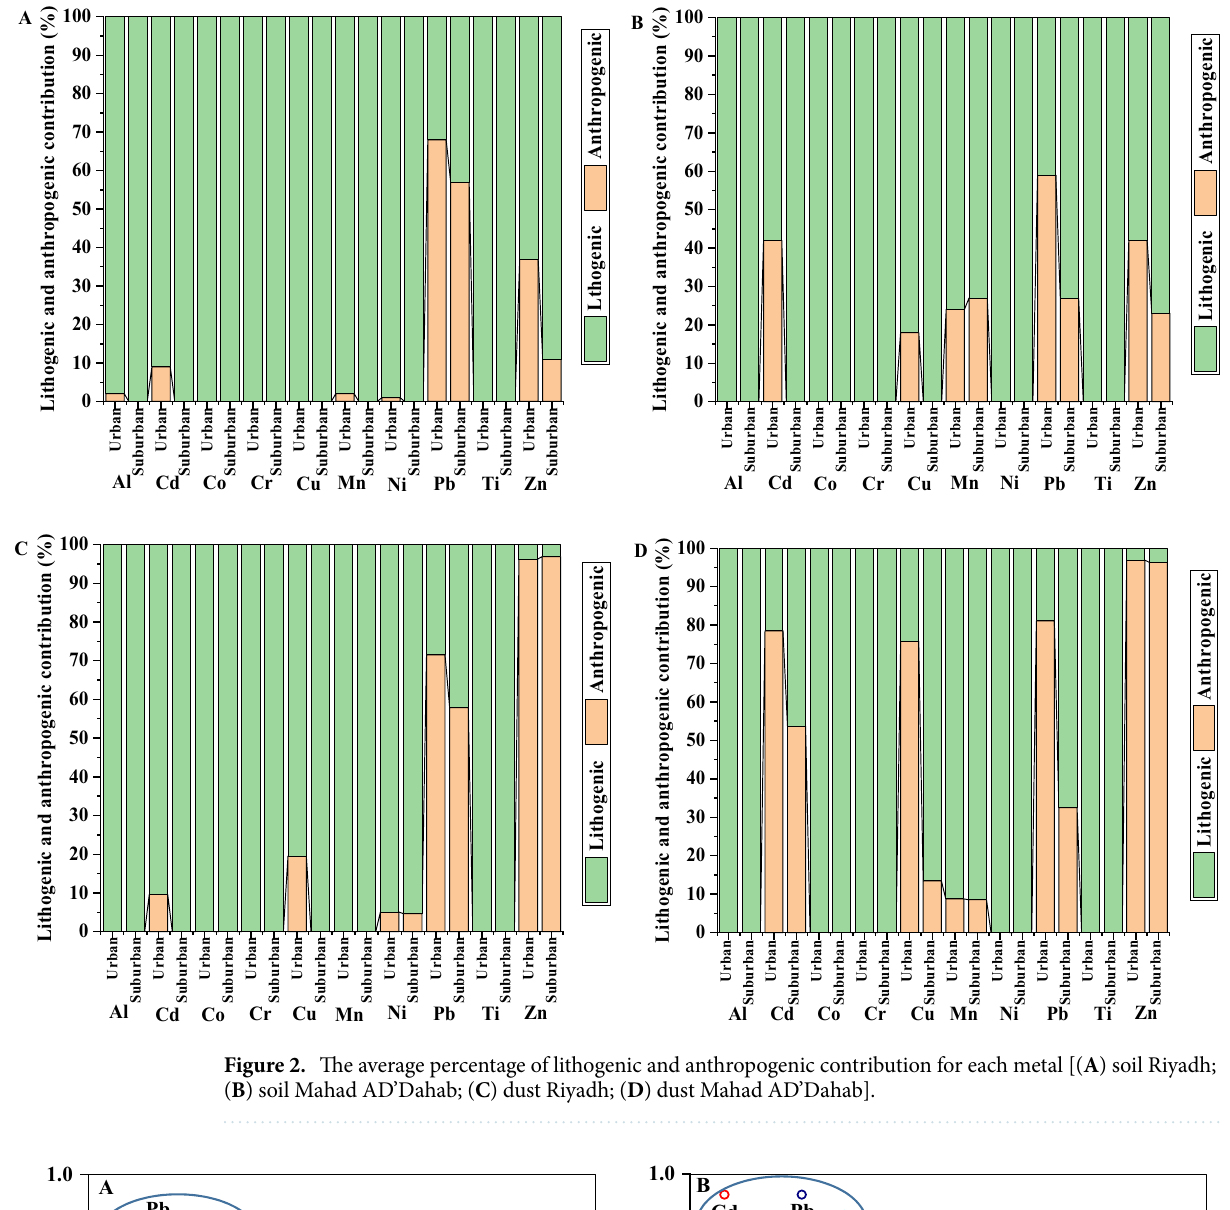
Figure 2. The average percentage of lithogenic and anthropogenic contribution for each metal [( A ) soil Riyadh; ( B ) soil Mahad AD’Dahab; ( C ) dust Riyadh; ( D ) dust Mahad AD’Dahab].